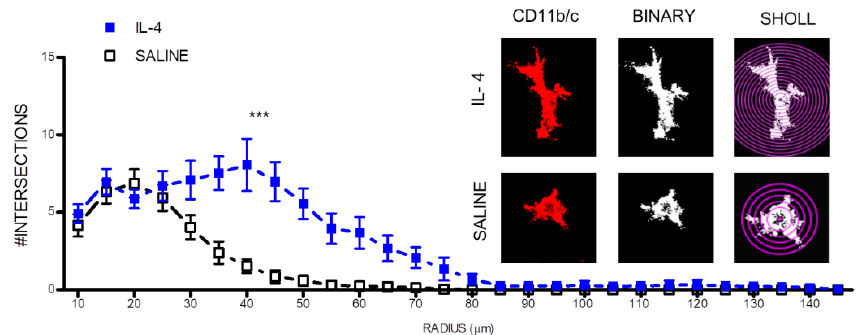
Figure 4. IL-4 treatment promotes a more ramified morphology (less active) on macrophages/microglia. On the right, microglia immunofluorescence images were transformed into binary and then analyzed with a sholl plot. Then, it was quantified the number of intersections with each sholl plot concentric circle. *** p < 0.001.